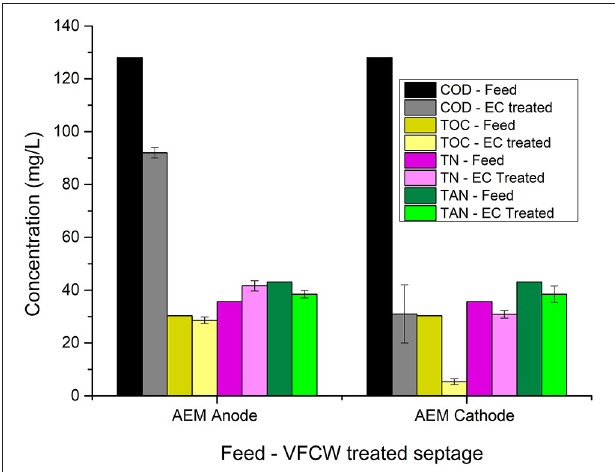
FIGURE 8 | Variation in wastewater parameters of VFCW treated septage after 90min of electrolysis in anode and cathode chamber recirculation in ECR with AEM.